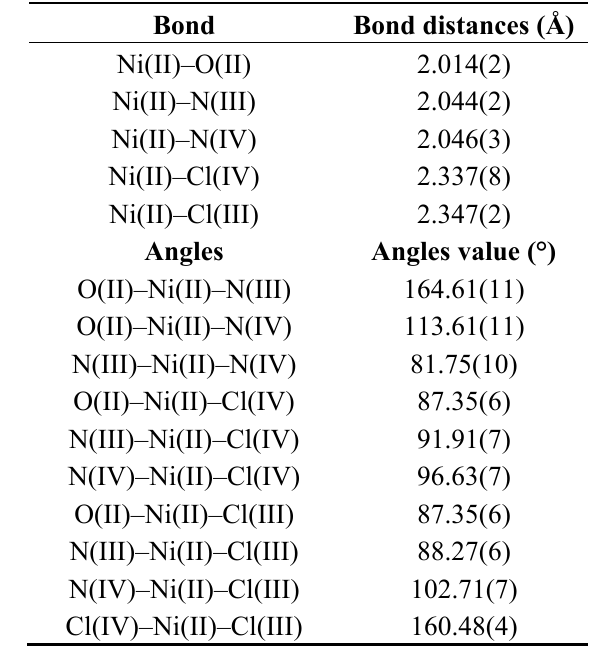
Table 1. Selected bond distances (Å) and angles (°) of the